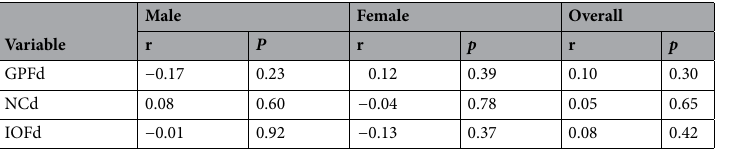
Table 4. Pearson’s correlation coefficients (r) describing the relationships between age at T1 and the annual change of each variable measured. No statistically significant correlations ( p > 0.05). GPFd: Transverse linear distance between greater palatine foramina. NCd: Transverse linear distance between nasal cavity walls. IOFd: Transverse linear distance between infraorbital foramina.